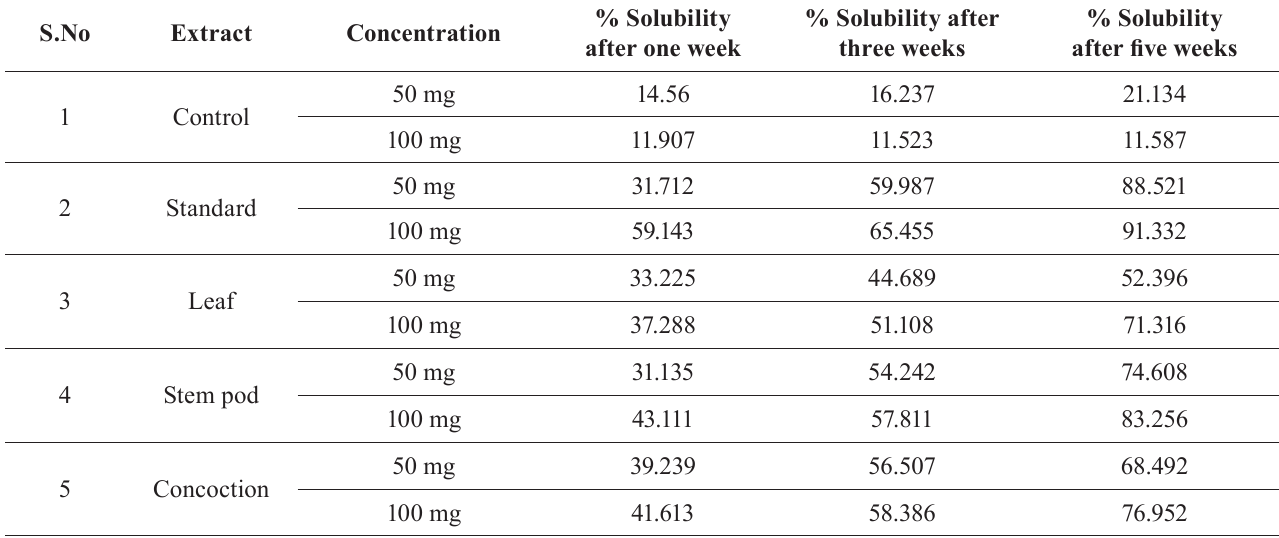
TABLE III - % Solubility of calcium oxalate tablet during treatment